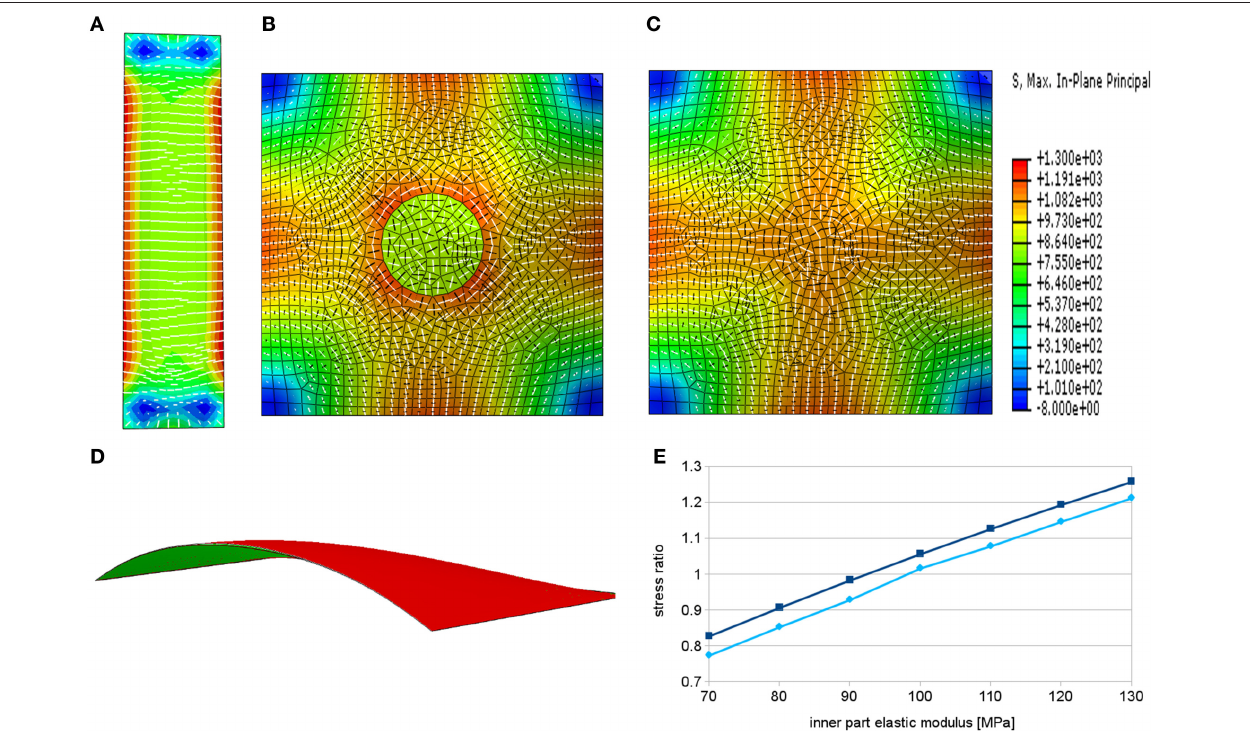
FIGURE 3 | Principal stress directions predicted by finite element models in root hair cells. White bars show the direction of the maximal principal stress, the black bars indicate minimal principal stress directions and the color represents the maximal stress magnitude. (A) Pattern of maximal principal stress in the epidermal wall of a pressurized rectangular cell bears resemblance to microtubular patterns of an approximately rectangular root epidermal cell except in the region of subsequent root hair outgrowth. (B) In case of softened material in the center of the patch we observe circumferential alignment of maximal principal stress around this region. (C) Increasing the elastic modulus of the material in the same region leads to radial organization of maximal principal stress around the center. (D) Cross section through the pressurized model showing the curvature of the surface and a slight difference in deformation between the simulation with the softened center (red) and the hardened center (green). (E) Graph showing dependence of the ratio of radial to circumferential stress components on the elastic modulus of this part in two points around the region of modified material in the center. The elastic modulus of the remaining part of the model was set to 100 MPa. The ratios below one correspond to the dominant circumferential stress direction while the ratios above one signify the dominant radial stress